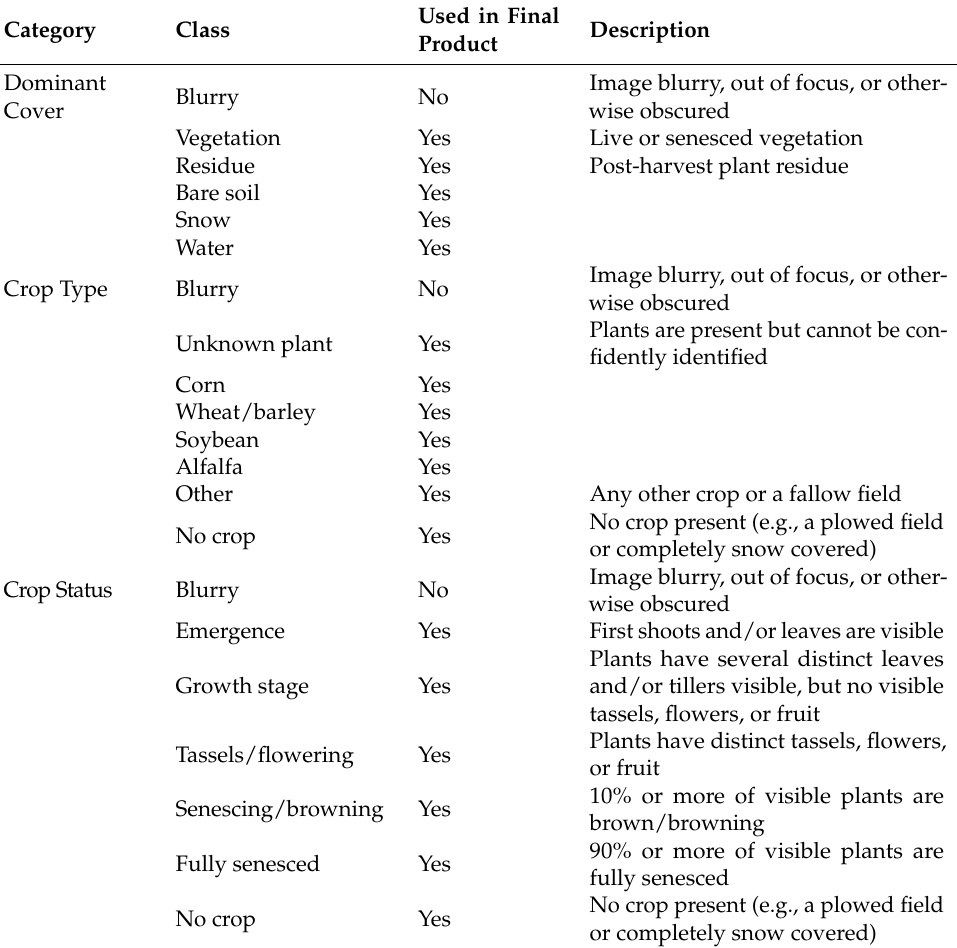
Table 1. Class descriptions used in the classification